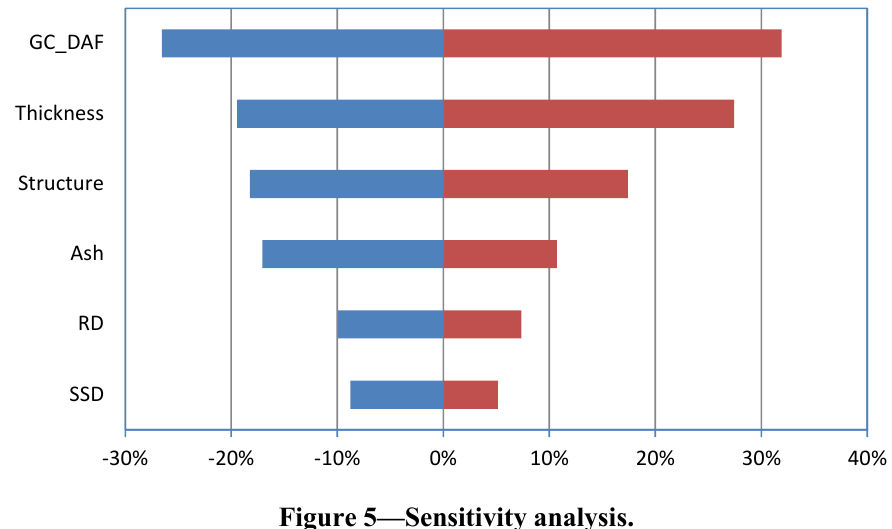
Figure 5—Sensitivity analysis.